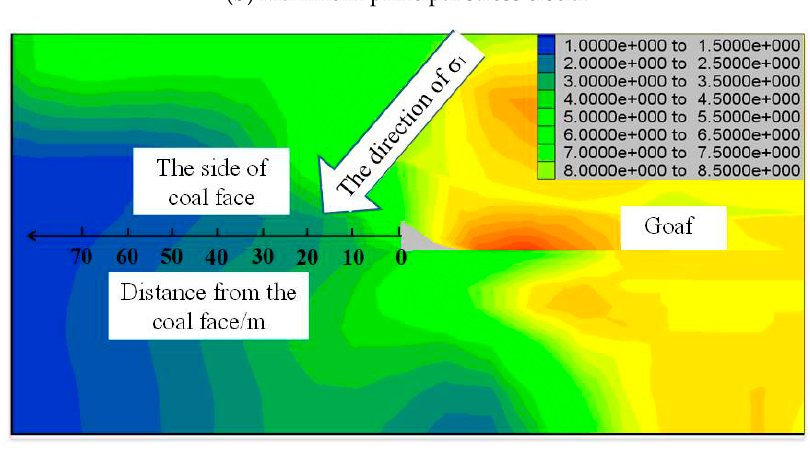
Figure 5. Principle stresses distribution characteristics of goaf lateral side surrounding rock.